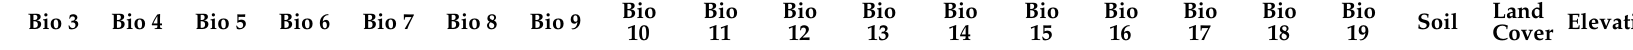
Table 3. Correlation coefficients (Rs) between 19 environmental variables, 2 topographical variables (elevation, land cover) and soil using the SDM Tool box